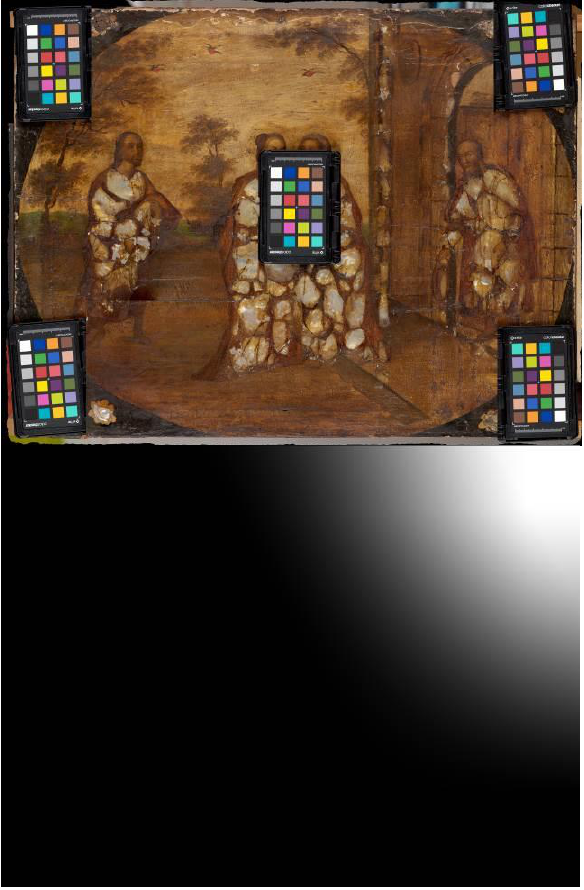
Figure 2. The colour checkers placed on the painting (top), and the gradient mask of the top-right colour checker for the simplified flat field correction